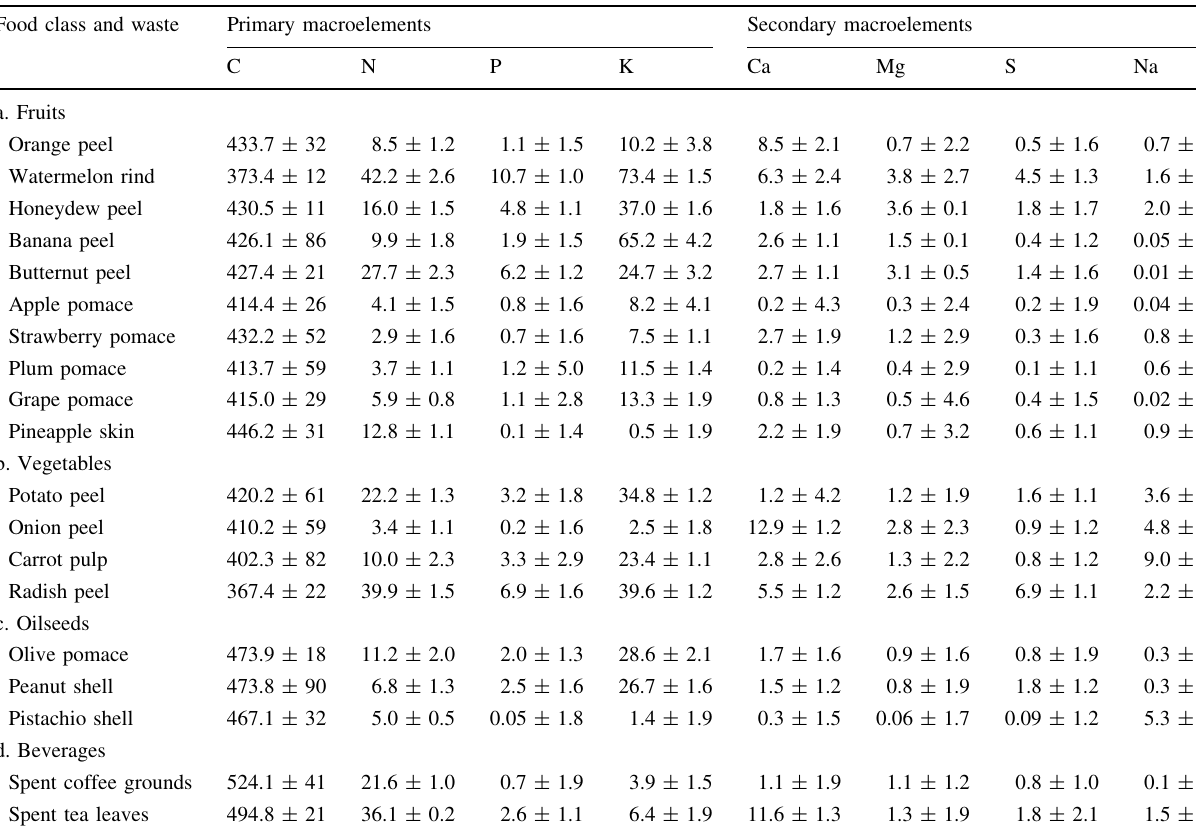
Table 1 Concentrations (mg g - 1 dry weight) of macroelements in different food